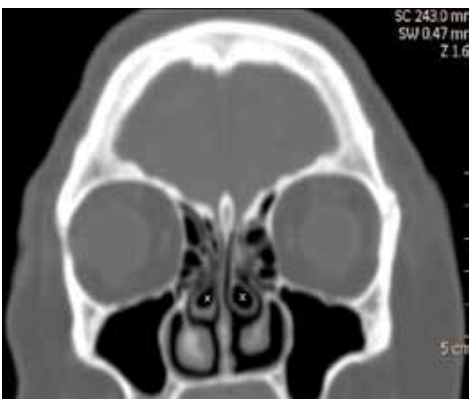
Fig. 11. Pneumatised superior nasal turbinate (arrow).Fig. 10. Bilateral concha bullosa (X).